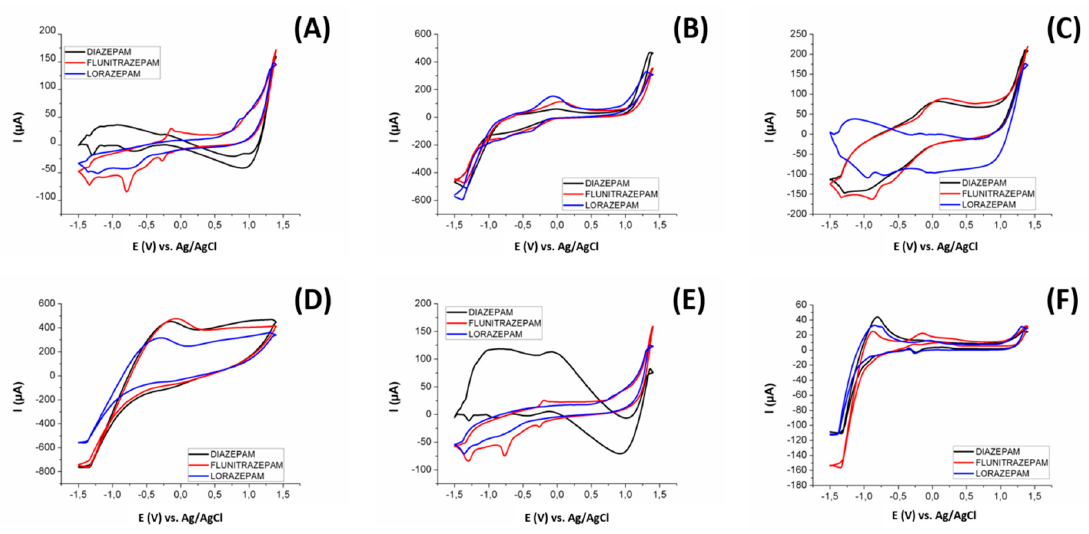
Figure 6. Voltammograms obtained with the three benzodiazepines used in this study (25 ppm) using a ( A ) bare epoxy-graphite composite electrode, and graphite electrodes modified with ( B ) CuO nanoparticles, ( C ) Cu nanoparticles, ( D ) Pt Nanoparticles, ( E ) WO 3 nanoparticles, and a ( F ) Pt metal